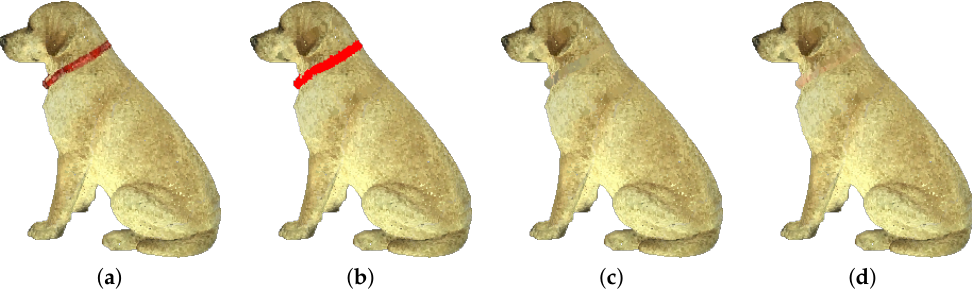
Figure 3. Inpainting of the color on a point cloud. ( a ) Original point cloud; ( b ) point cloud to inpaint, where the red color represents points to inpaint; ( c ) result of inpainting with w = 1; ( d ) result of inpainting with the patch-based similarity metric (see Section 4.2).